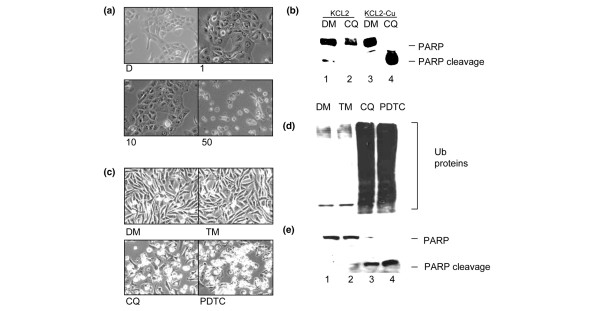
Induction of apoptosis in premalignant-MCF10 breast cells and proteasome inhibition and apoptosis induction in breast cancer MDA-MB-231 cells cultured to contain elevated copper and post-treated with clioquinol (CQ) and pyrrolidine dithiocarbamate (PDTC). (a,c) Premalignant-MCF10 (KCL2) cells were cultured in media containing 25 μM copper for two weeks. (b,d,e) MDA-MB-231 cells were cultured in 25 μM copper for 48 h. After culturing, cells were washed with PBS and treated with media containing: (a) 1, 10, or 50 μM CQ; (b-e) 25 μM CQ; 25 μM tetrathiomolybdate (TM); or (b,d,e) 10 μM PDTC. An equivalent volume of DMSO (DM) was used as control. KCL2 and MDA-MB-231 cells were examined for (a,b) apoptotic morphology and (c,e) PARP cleavage. (d) MDA-MB-231 cells were also examined by western blot for accumulation of ubiquitinated proteins. (a,c) KCL2 cells containing clinically relevant levels of copper were sensitive to treatment by CQ alone, which induced apoptosis. (c) KCL2 cells cultured under standard conditions were resistant to treatment by 25 μM CQ. Similarly, MDA-MB-231 cells cultured to contain elevated copper were sensitive to CQ or PDTC and underwent proteasome inhibition as measured by accumulation of (d) ubiquitinated (Ub) proteins and apoptosis as evidenced by morphology and (b,e) poly (ADP ribose) polymerase (PARP) cleavage. These data suggest that KCL2 and MDA-MB-231 cells cultured to contain clinically relevant levels of copper are sensitive to treatment with CQ or PDTC alone, but not TM.